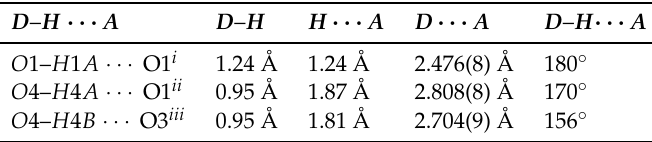
Table 1. Hydrogen bonding interactions in compound 1 . Symmetry codes i : 1 − x , 2 − y , − z